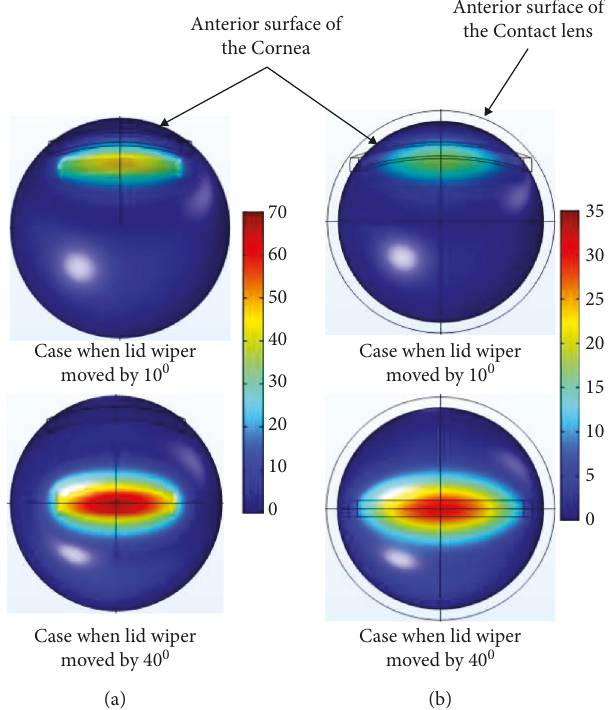
Figure 9: Contour plot of the displacement in the cornea during blink without CL (a) and with CL (b) when the lid wiper is moved at superior (10 ° ) and central position (40 ° ) of the cornea (value of the legend shows displacement; unit: µ m). The plots were exported as images from COMSOL Multiphysics v5.2 (https://www.comsol.com), and image collage was made using Microsoft PowerPoint 2019